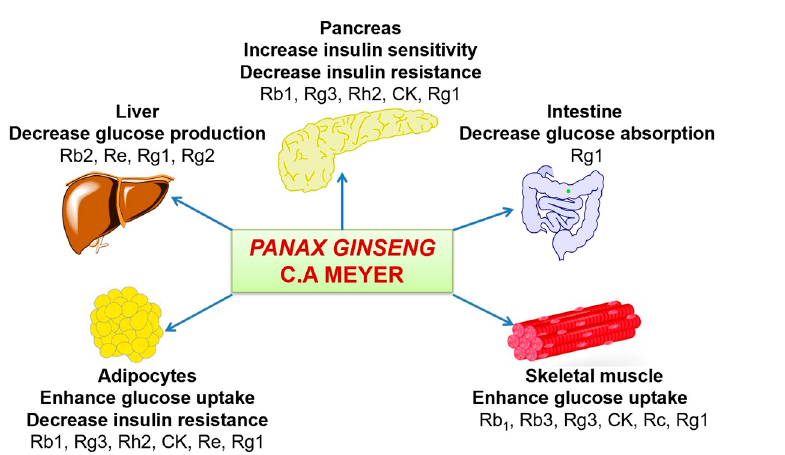
Figure 6. Mechanisms of Panax ginseng saponins on different organs related to diabetes.